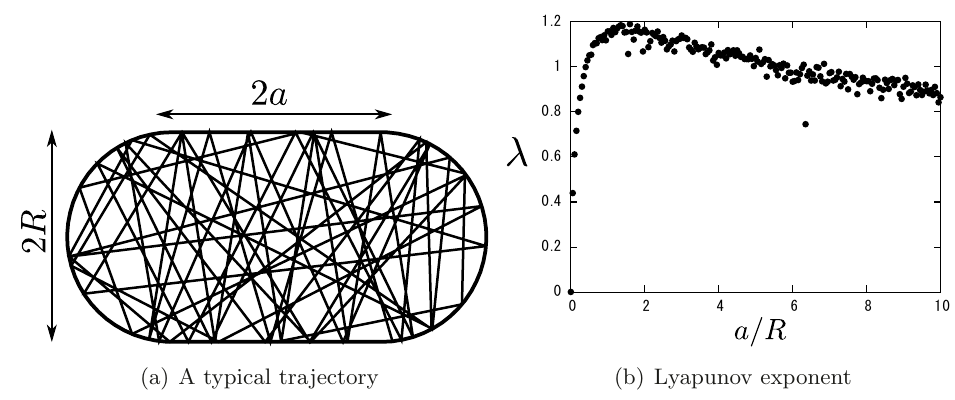
Figure 4 . A typical trajectory of a classical particle in the stadium billiard with a/R = 1. The maximum Lyapunov exponent vs deformation parameter a/R for fixed area of the stadium and velocity of the particle, A = v =